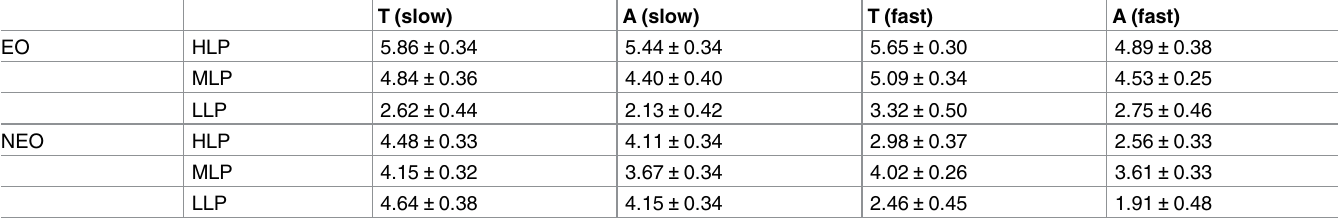
Table 4. VAS score (0–10) at slow and fast swimming pace (data are means ± SE).